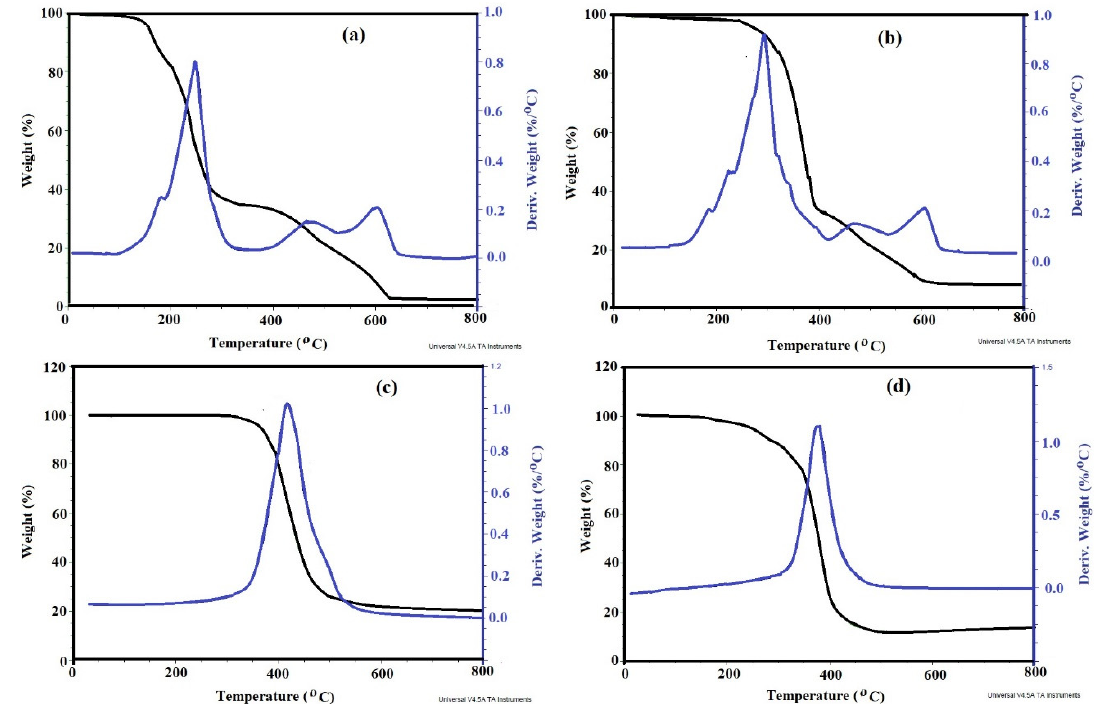
Figure 7. TGA-DTG thermograms of the cured epoxy / polyamine hardener in the presence 5 wt.% of ( a ) SG, ( b ) AS, ( c ) STHc and ( d ) STHa.